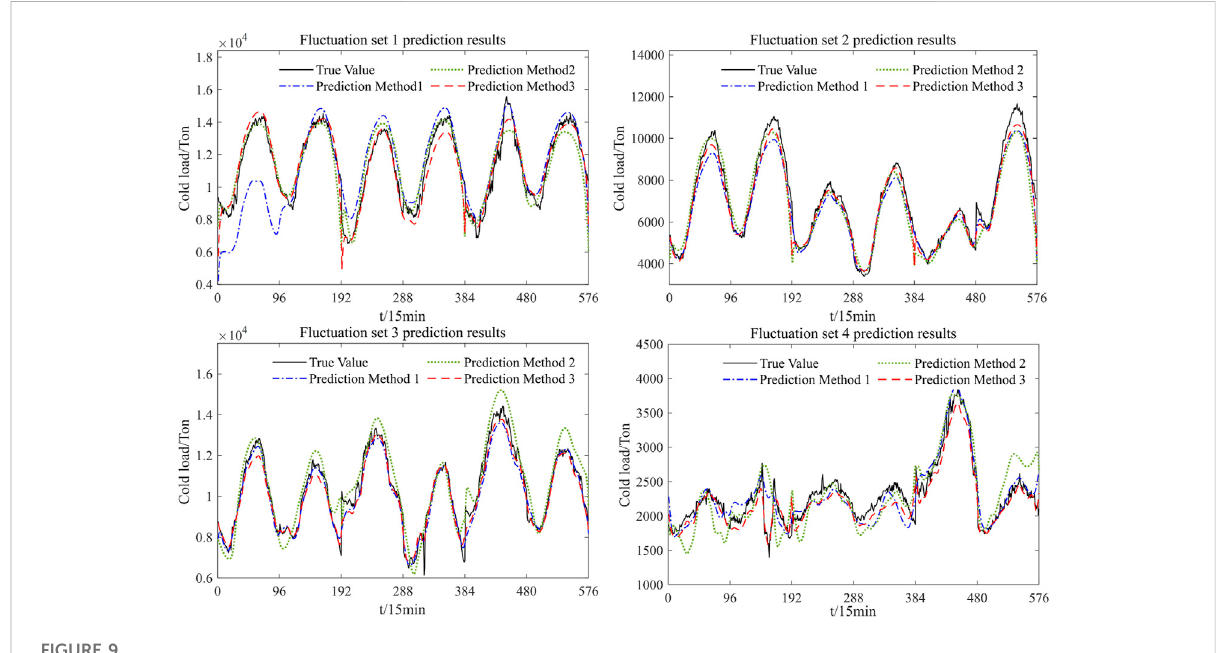
FIGURE 9 Cold load prediction results.